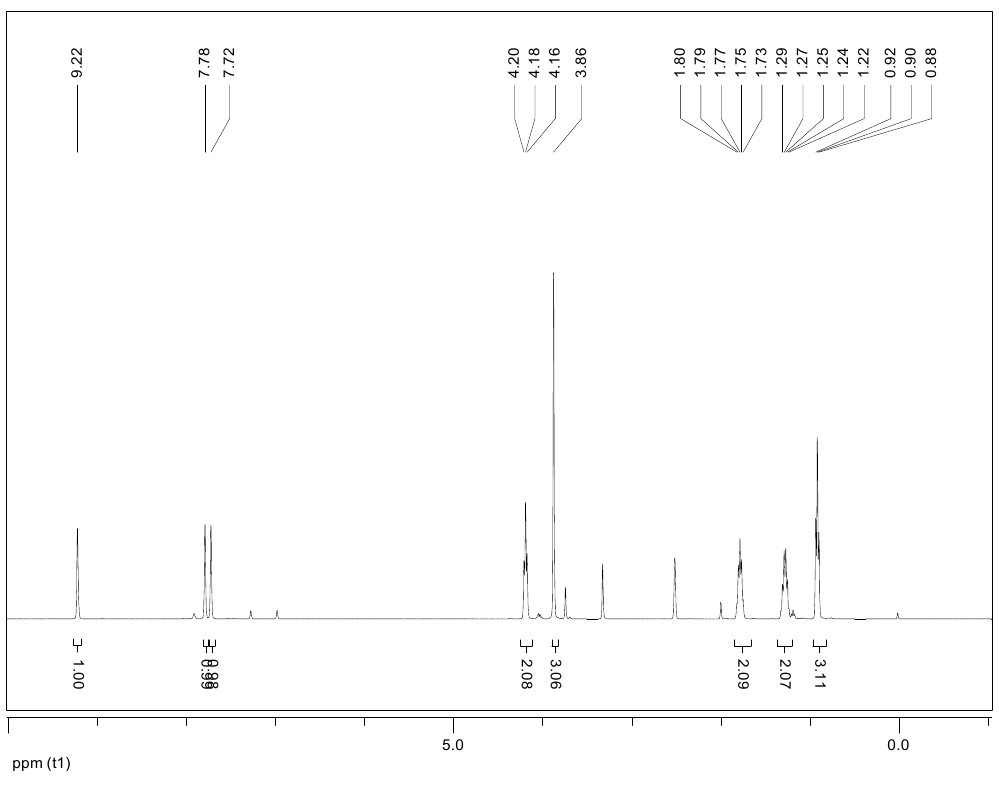
Figure 7. NMR spectra of recovered [Bmim]ZnCl